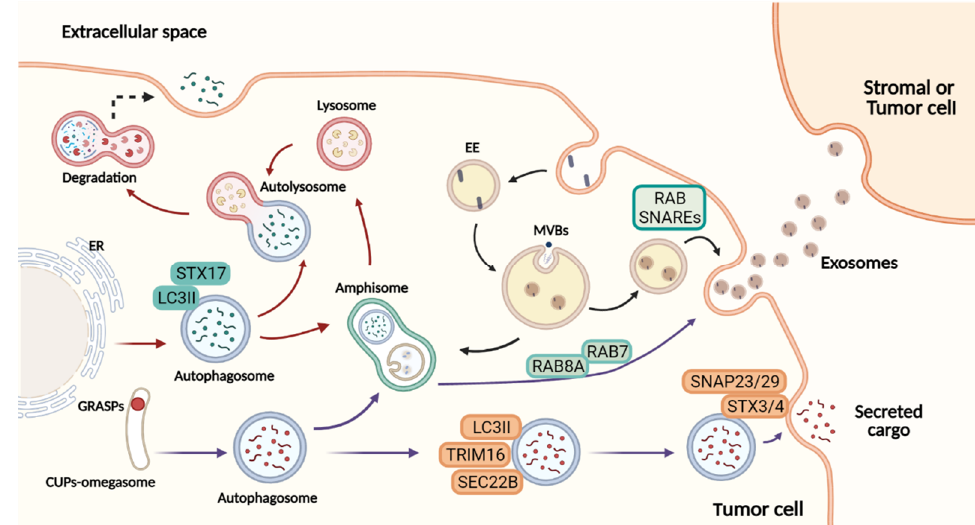
Figure 1. Overview of autophagy-dependent secretory pathways and exosome release. Figure cre- ated with BioRender.com.At the ER exit sites, omegasomes contribute to the formation of degradative autophagosomes. LC3II is recruited to the autophagosome membranes, where it mediates mem- brane expansion. Autophagosomes fuse with lysosomes to form autolysosomes, and their lysosomal hydrolases degrade the cytosolic cargo selected. In a secretory autophagy, the autophagosome is formed by an omegasome-like structure similar to CUPs, near to the ER exit sites. This autophago- some requires TRIM16 for cargo selection, and SEC22B to be addressed to the plasma membrane completing the fusion via complementary SNAREs. Both in the degrading and the secretory path- way, the autophagosome may fuse with the MVBs, generating amphisomes that can either fuse with lysosomes and degrade their content or fuse with the plasma membrane secreting cargo to the ex- tracellular space. Exosome biogenesis initiates from invaginations of the plasma membrane to form early endosomes followed by maturation and inward membrane invaginations to generate ILVs. Further, the MVBs (later endosomes) will fuse with the plasma membrane to extracellularly release the cytosolic components of ILVs as exosomes. The cargo secreted to the extracellular milieu con- tributes with the transference of several molecules upon the uptake by recipient cells. In this man- ner, secretory autophagy and exosomes orchestrate multiple systemic processes. Red arrows: deg- radative autophagy. Purple arrows: secretory autophagy. Black arrows: exosome biogenesis. ER: endoplasmic reticulum. EE: early endosome. MBVs: multivesicular bodies. ILVs: intraluminal vesi- cles. 2.2. Branches of the Secretory Autophagy System Recent evidence showed a novel mechanism, where LC3 is implicated in the loading of RNA-binding proteins (RBPs) and small non-coding RNAs within EVs. This process, named LC3-dependent EV loading and secretion (LDELS), requires the LC3 conjugation machinery; however, no other ATGs are involved in degradative autophagy, representing an alternate route for the EVs cargo secretion. In LDELS, LC3 and vesicular cargo are de- livered to the limiting membrane of MVBs, where the cytosolic cargo undergo budding, generating intraluminal vesicles (ILVs) within the MVBs that subsequently are released as extracellular vesicles. Importantly, when these EVs were isolated and fractionated, it was observed that LC3 was in the lumen of EVs, thus corroborating that LC3 is secreted within EVs [29]. Afterwards, another elegant study from the same group revealed a dif- ferent secretory autophagy route in response to the endolysosome inhibition. They showed that the inhibition of lysosome acidification by bafilomycin A1 activates secretory autophagy of autophagy elements and cargo receptors in EVs fractions, both in vitro and in vivo [30]. In contrast to LDELS, the cargo is not loaded selectively into EVs, being ex- posed to proteolysis instead. Thus, these proteins are released in association with EVs, but as a fraction of nanoparticles, named extracellular vesicles and particles (EVP) [31]. Thus, this secretory pathway is dependent on several ATG as well as endosomal markers, such as Rab27a, which are responsible for the exocytosis of EVPs. In addition, the impairment